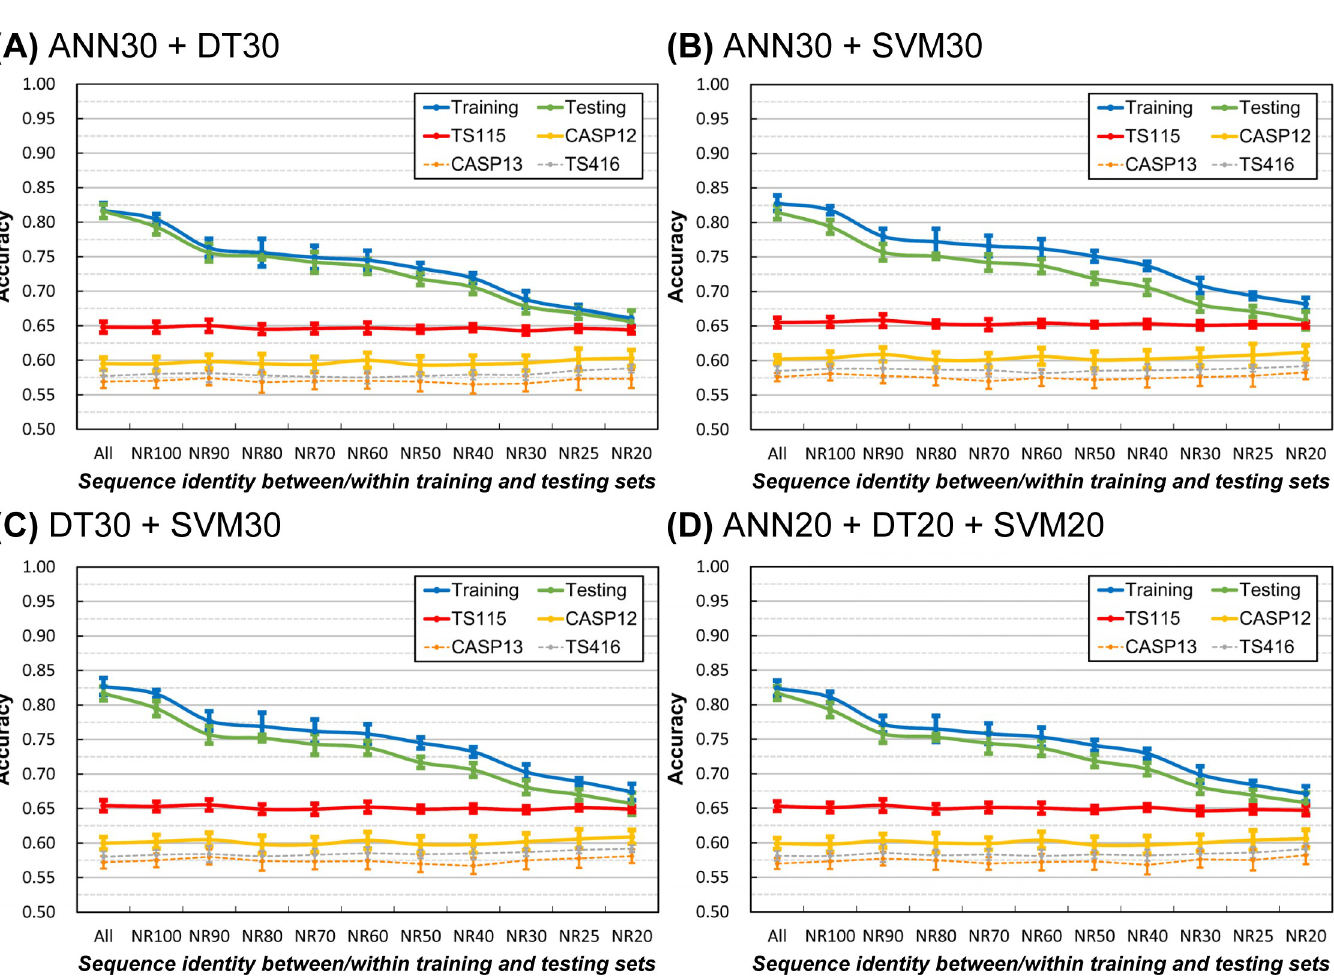
Fig 12. The SSP accuracy of combined machine learning algorithms obtained with training and testing datasets sharing decreasing levels of sequence homology. (A) Random forest of 30 artificial neural networks and 30 decision trees. (B) Random forest of 30 artificial neural networks and 30 support vector machines. (C) Random forest of 30 decision trees and 30 support vector machines. (D) Random forest of 20 artificial neural networks, 20 decision trees, and 20 support vector machines. The layout of this experiment was the same as in Fig 10. Using the iMLS system’s bootstrapping function, random forests of several different machine learning algorithms were constructed. For fair assessments, the number of “trees” in every forest was set to be 60. Although combining different algorithms helped average out the extent of overfitting (compare the gaps between the blue and green curves shown in Fig 11 and this figure), the improvement in accuracies evaluated by independent tests was